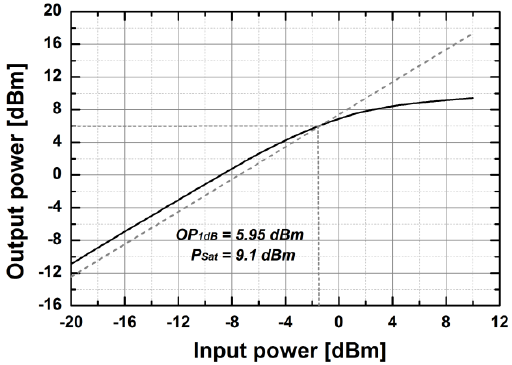
Figure 15. The simulated input/output power characteristics of the BDGA.